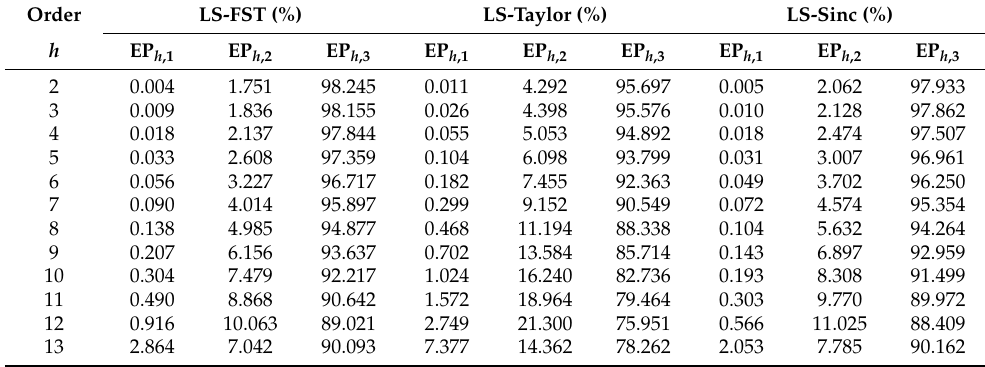
Table 1. Each part proportion of the harmonic amplitude estimation error obtained by different least-square